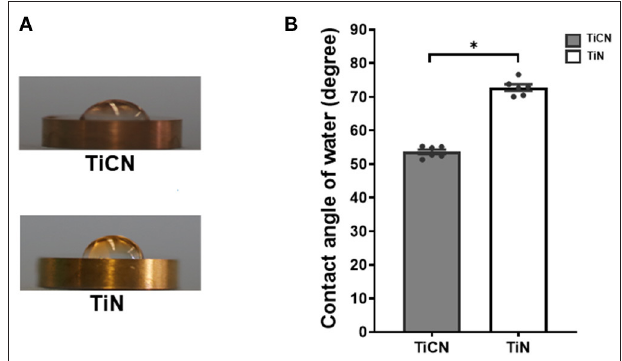
FIGURE 1 | Hydrophilicity evaluation of titanium carbon nitride (TiCN) and titanium nitride (TiN) coatings by contact angle measurement of 10 µ l ddH 2 O. (A) Representative images of 10 µ l ddH 2 O placed on TiCN (upper panel) and TiN (lower panel) coatings. (B) A histogram representing the average contact angles with standard error of mean on TiCN (gray bars) and TiN (yellow bars) coatings. *indicates significant differences of p < 0.05.